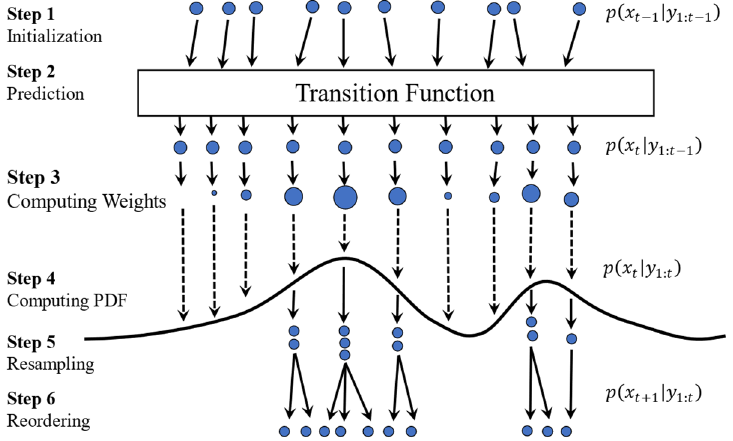
Figure 5. Steps associated with a Particle Filter approach with resampling. (1) Particle initialization (2) prediction; (3) computing weights; (4) computing PDF; (5) resampling; and (6) reordering.